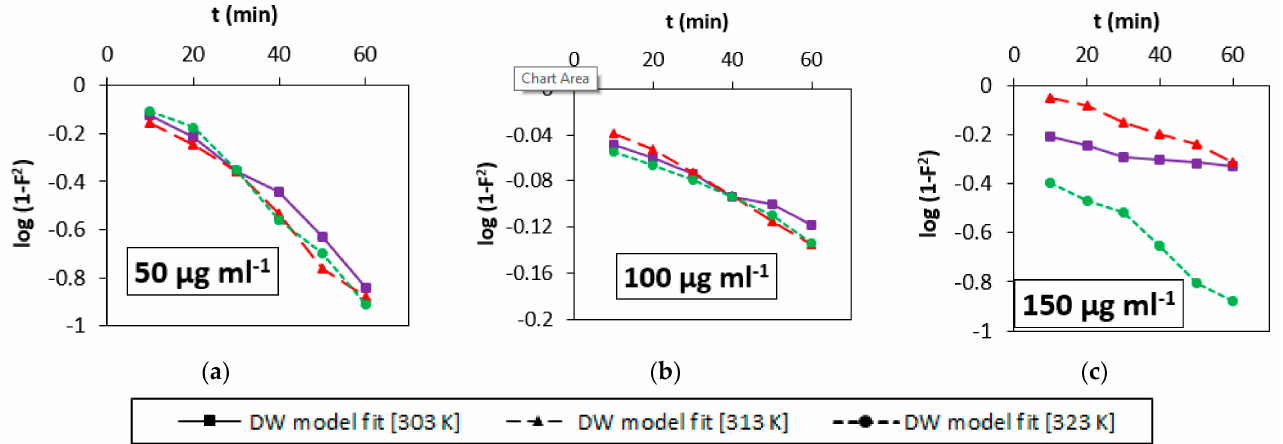
Figure 9. Energy Information fitted to the format of Dumwald-Wagner model with initial BG focus ( a ) 50 µ g/mL, ( b ) 100 µ g/mL, and ( c ) 150 µ g/mL.